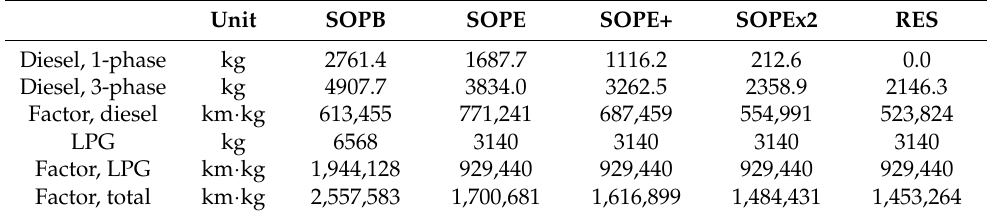
Table 4. Lifecycle inventory data for the transport of energy carriers to the hut for 1 year of the hut’s operation.